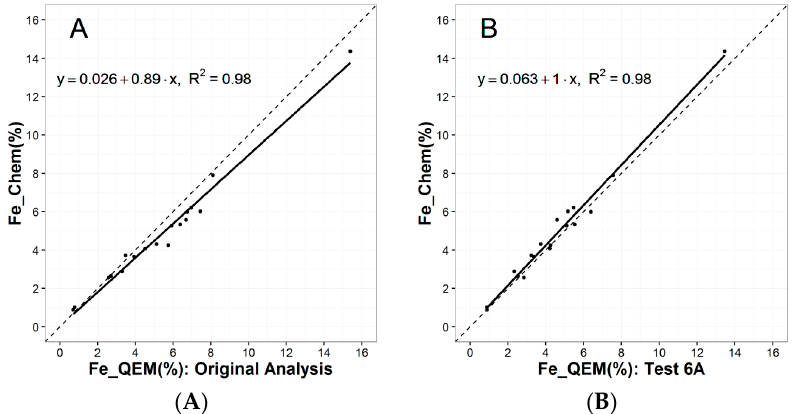
Figure 6. ( A ) Elemental conciliations for Fe for eighteen samples, comparing QEMSCAN ® results vs.